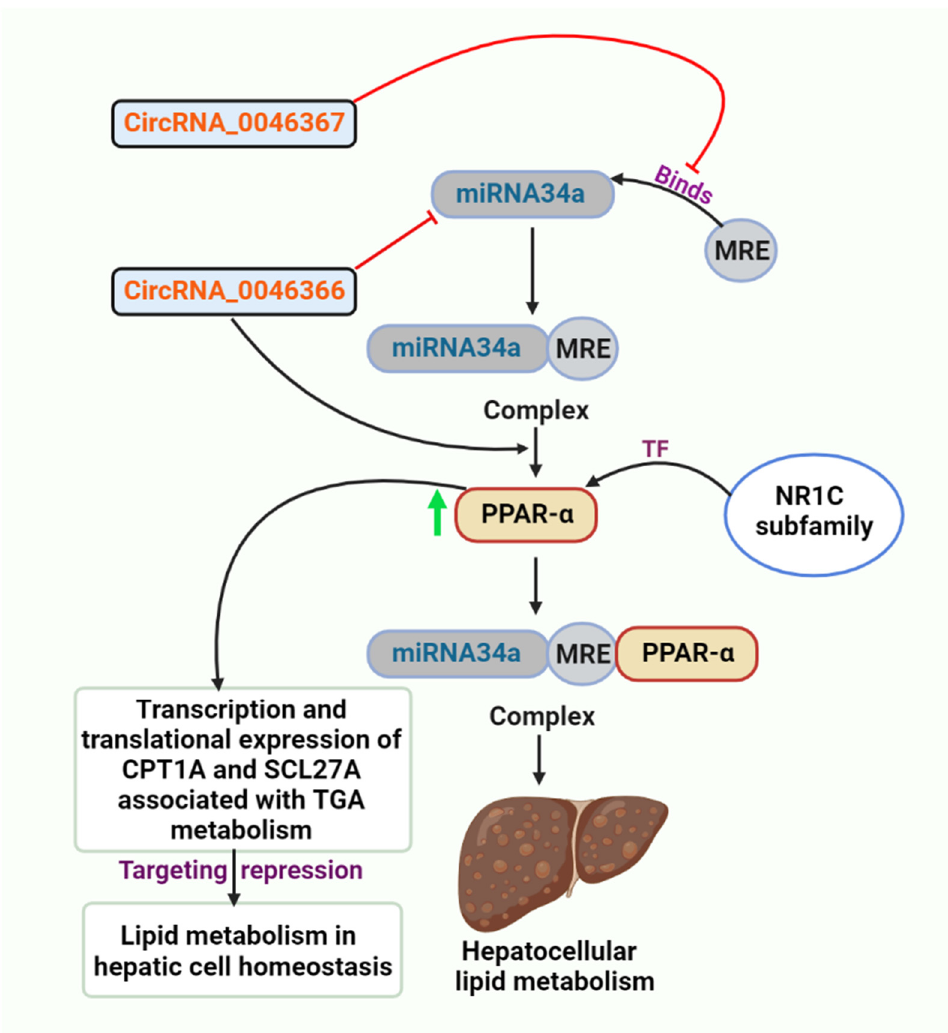
Figure 2. The figure depicts the inhibitory role of circRNA_0046367, preventing MRE from binding miRNA34a, and the role of circRNA_0046366 in inhibiting miRNA34a. circRNA_0046366 exerts its influence mostly on metabolic processes, particularly lipid metabolism. Recent research identifies PPAR α , an NR1C nuclear receptor subfamily transcription factor, as a direct target of miR-34a [120]. This type of liver-specific, ligand- activated PPARs isoform stimulates the expression of several genes with lipometabolic properties [159]. In obese patients, the absence of PPAR α confers a high risk of insulin resistance, depletion of n-3 long-chain polyunsaturated fatty acids, and liver steatogenesis [160]. Accumulating data show a miR-34a/PPAR α regulatory mechanism, which is the essential mediator of circRNA_0046366 effects on hepatic lipid metabolism (Figure 2). circRNA_0046366, whose expression was reduced in HepG2-based hepatocellular steatosis, inhibits the function of miR-34a. Silencing of miR-34a eliminates its inhibitory effect on PPAR α and restores PPAR α expression [161]. PPAR α restoration enhances the expres- sion of TG metabolism-related downstream genes [i.e., carnitine palmitoyl transferase 1A (CPT1A) and solute carrier family 27A (SLC27A)] at the transcriptional and translational levels. miR-34a is highly upregulated in multiple rodent hepatic steatosis models [162,163], and its expression persistently corresponds well with the clinical presentation of hepatic steatosis in Chinese [87], Japanese [164], and Philippine populations [165]. Targeted inhibition of PPAR α underlines the steatosis-related action of miR-34a [120]. Targetome and targetome-based pathway analyses of miR-34a were merged to identify the miRNA-